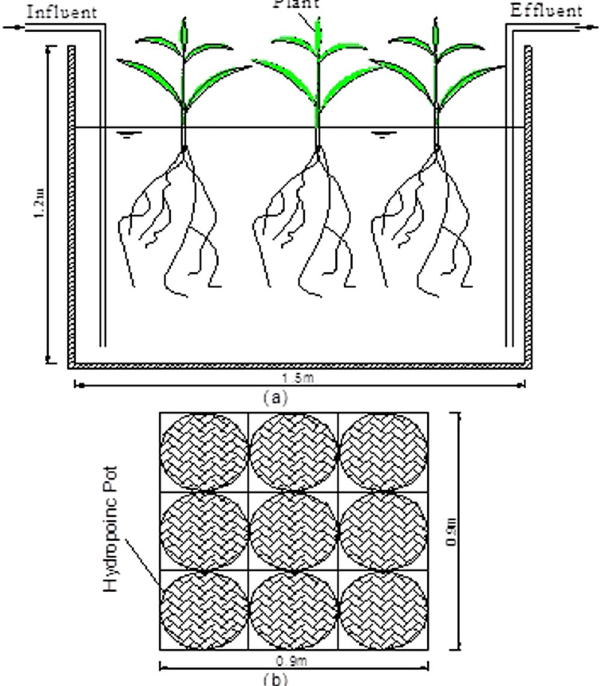
Figure 5. Schematic representation of the experimental system: ( a ) tank and ( b ) constructed floating bed unit.